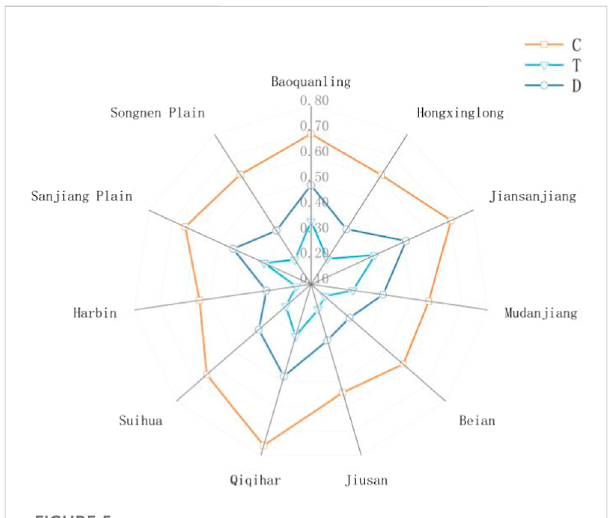
FIGURE 5 Coupling and coordination degree of GU-CL in